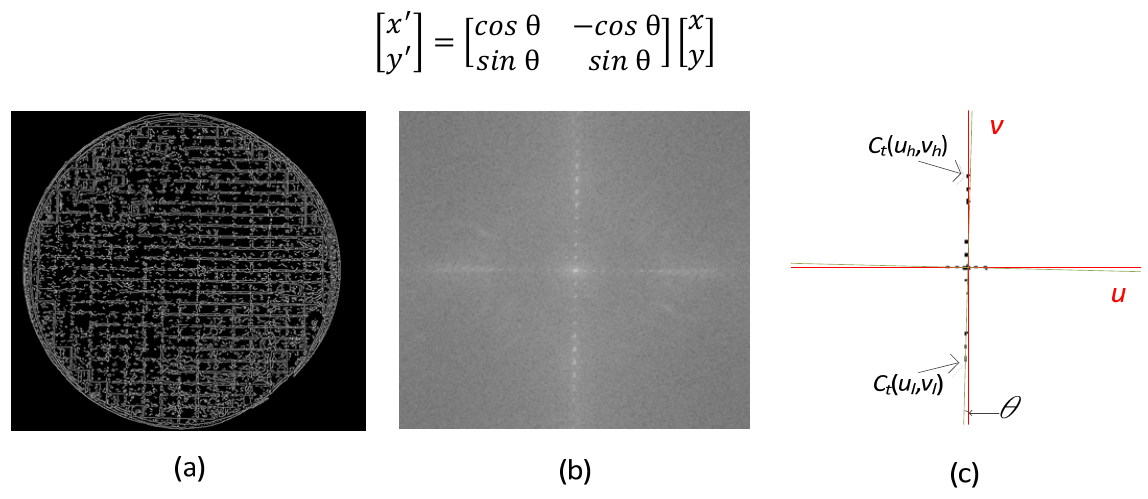
Figure 4. ( a ) Canny edge detection result of Figure 3b; ( b ) spectrum of the edge image shown in Figure 4a; ( c ) binary image in which the black points are corresponding to strong white points shown in Figure 4b.